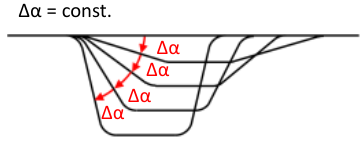
Figure 9. Forming sequence with constant profile depth increase in each roll pass.